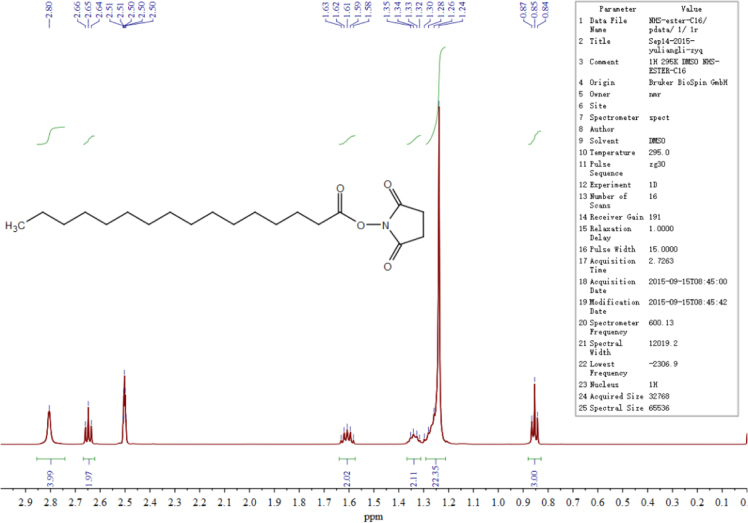
1H NMR spectrum of C16-NHS.